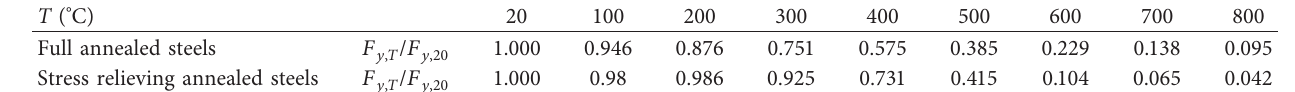
Table 10: Ramberg–Osgood hardening parameters from regression fitting, with K